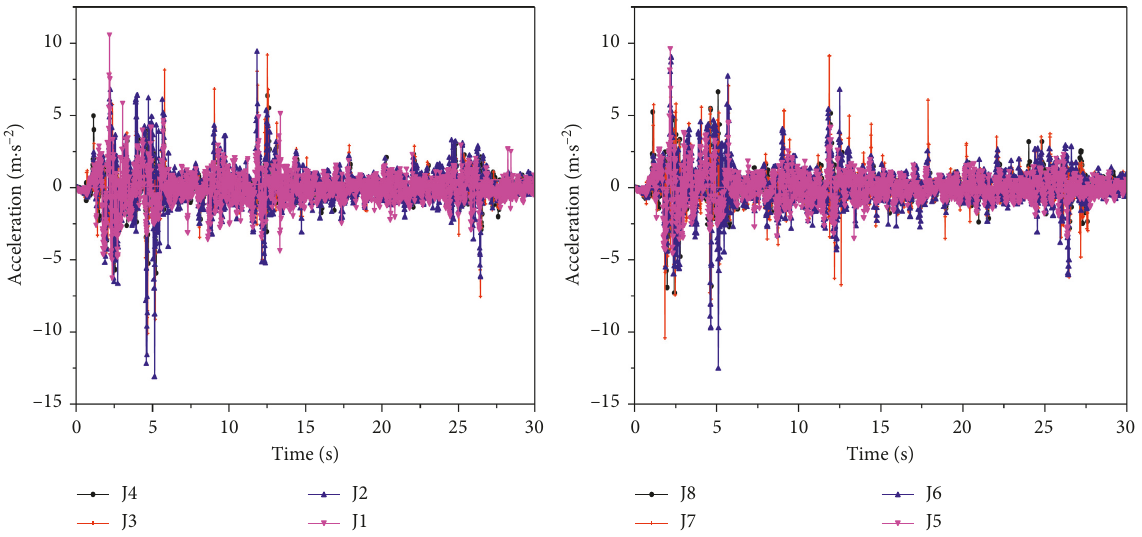
Figure 11: Acceleration of soil under the 0.5g El Centro seismic wave.